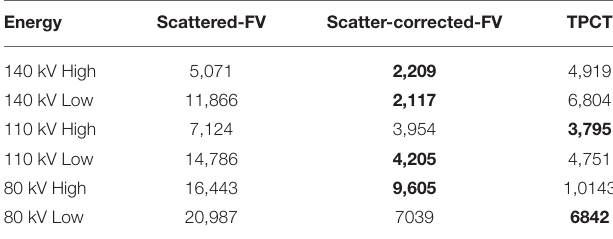
TABLE 2 | The MSEs of different algorithms.